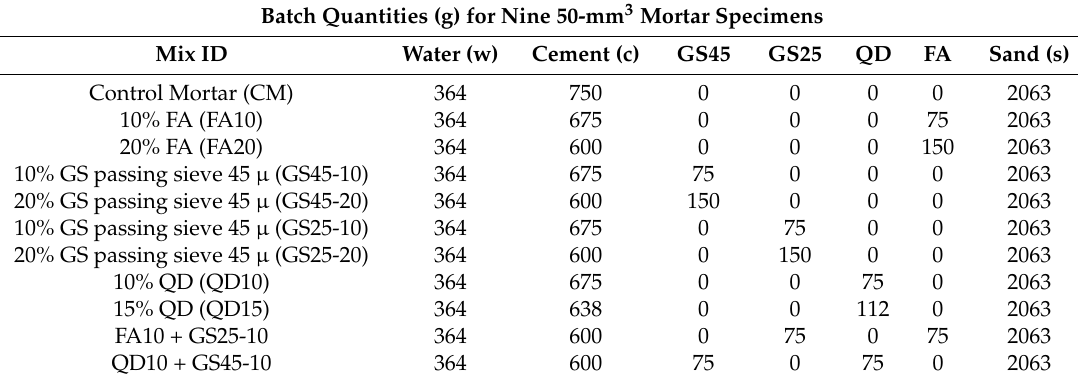
Table 4. Mixture proportions of mortar (w/cementitious materials (cm) = 0.485; cm:s =